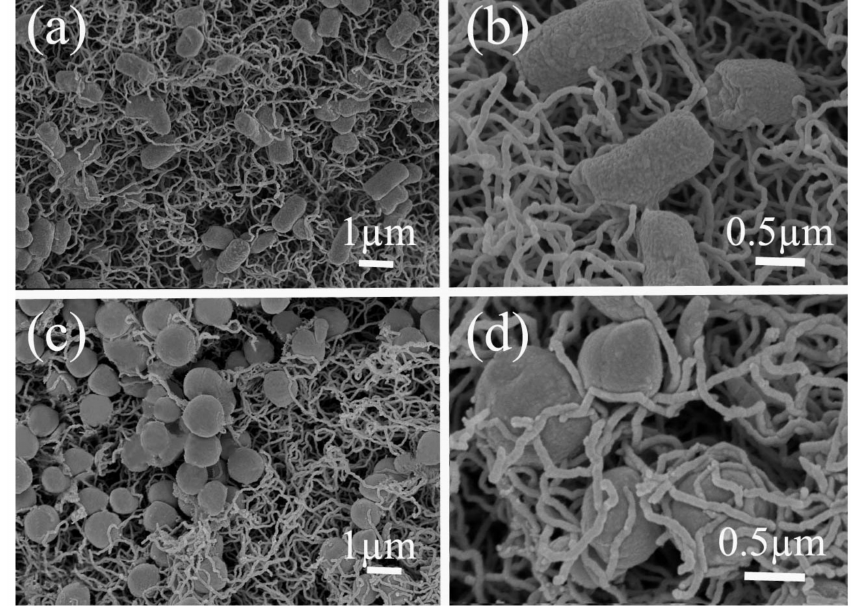
Figure 9. SEM images of E. coli ( a , b ) and S. aureus ( c , d ) on the mullite–CNT composite membrane after the filtration. High magnification view of the composite membrane with the captured E. coli ( b ) and S. aureus ( d